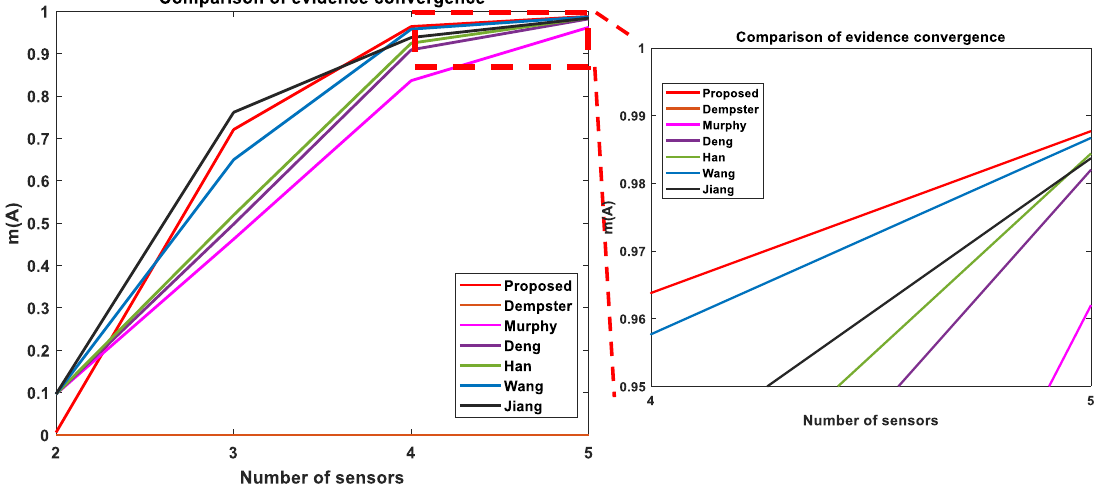
Figure 2. Comparison of convergence of evidence m(A) for Example